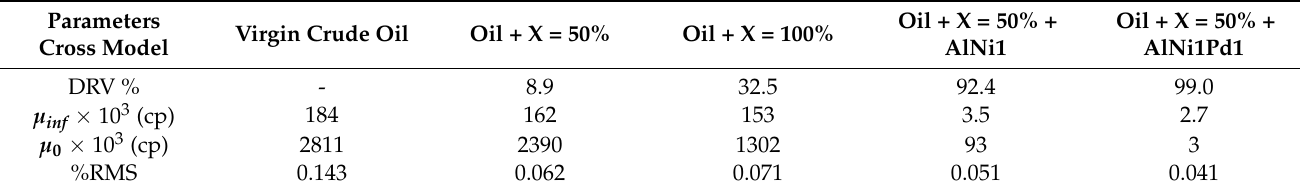
Table 4. Effect of steam injection at different qualities X = 0.5 and X 1.0 and catalytic steam injection at X = 0.5 in the presence of AlNi1 and AlNi1Pd1 in viscosity reduction degree (DVR) of an extra-heavy oil at 25 ◦ C—the shear rate of 10 s − 1 and rheological parameters of the simulated model of Cross.